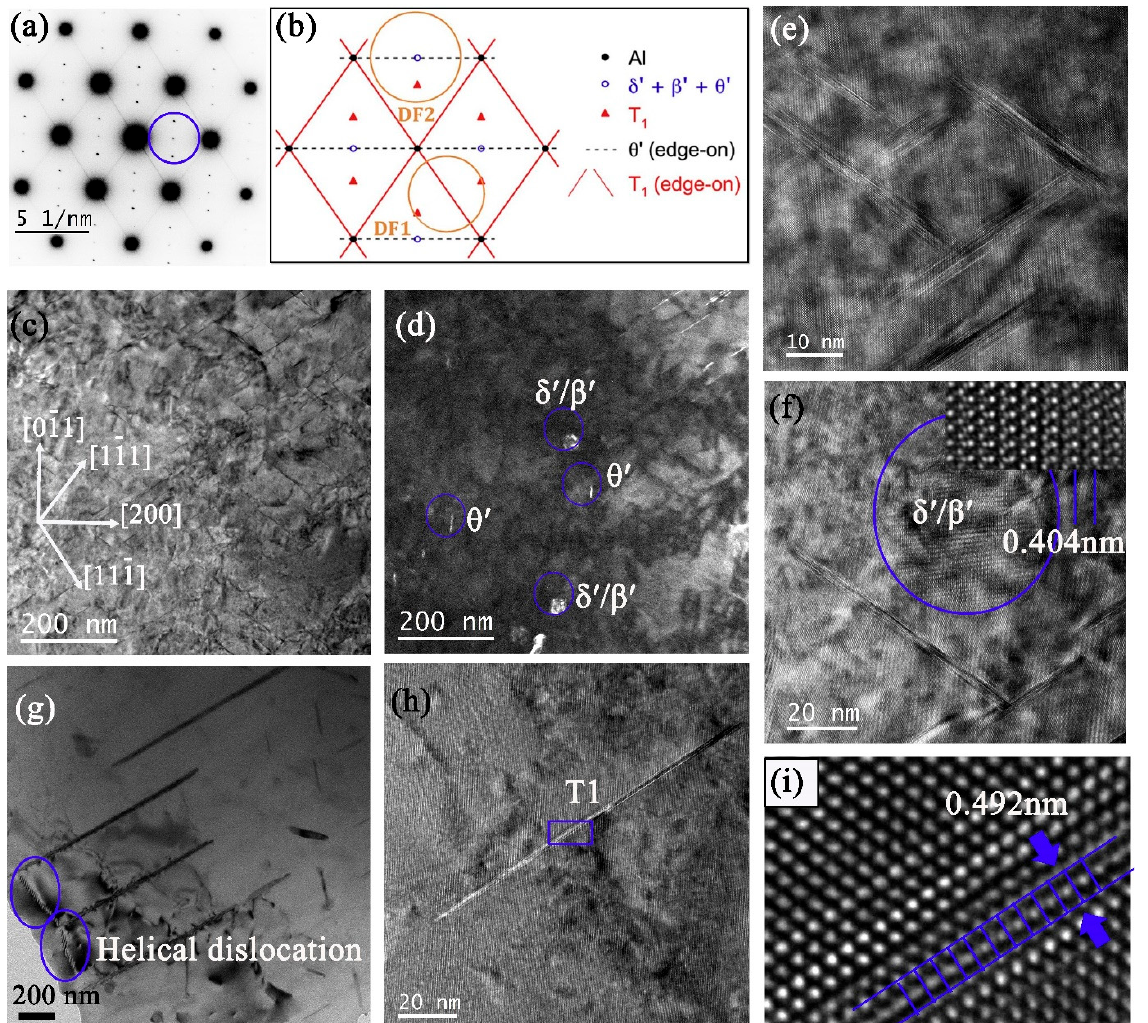
Figure 9. TEM analysis of 3# after 12 h creep. ( a ) SADP under [110] α zone axis and ( b ) corresponding schematic SADP. ( c ) BF and ( d ) DF of ( c ) by selecting the diffraction spots in ( a ) using a blue circle. ( e ) Enlarged T 1 phases forming a circle, ( f ) enlarged δ′ / β′ phases with inset HRTEM, ( g ) helical dislocations together with thick T 1 phases observed by multi-beam BF electron microscope technique, ( h ) a single long T 1 phase, and ( i ) HRTEM of ( h ).